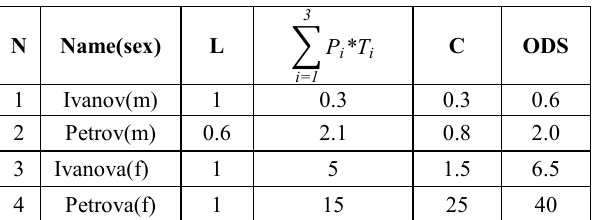
Table 2. ODS calculation